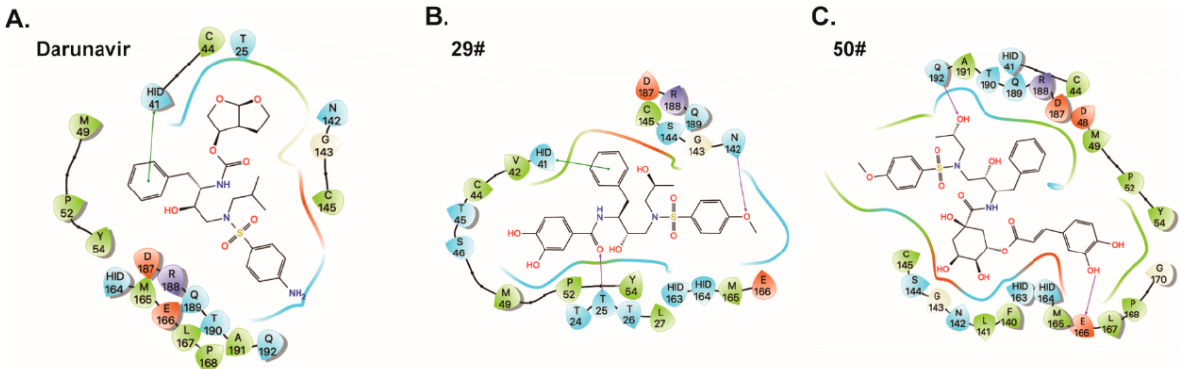
Figure 5. Predicted binding poses for darunavir ( A ) and its two derivatives ( B , C ). Residues within 5 Å of the compounds were shown on the 2D ligand interaction diagram. For clarity, only polar hydrogen atoms were shown. Here, the color code is that dark blue is positively charged, red is negatively charged, cyan is polar, and green is hydrophobic. Hydrogen bonding is depicted as the magenta arrows, π -cation interactions are depicted as the red line, and π – π interactions are depicted as the green line.